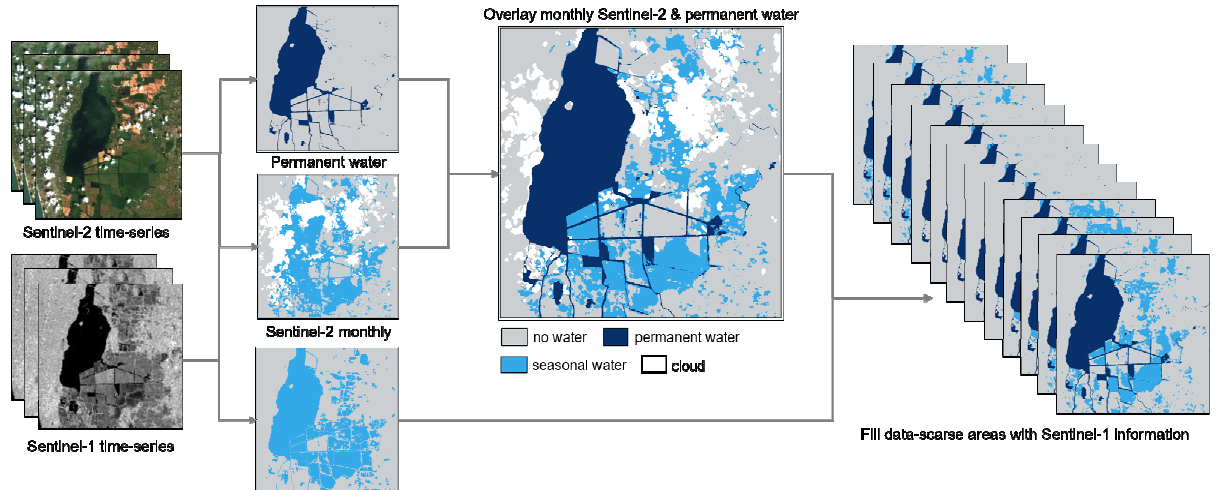
Figure 1. Methodology for generating permanent and monthly seasonal reference water masks using times-series analysis and fusion of Sentinel-1 and Sentinel-2